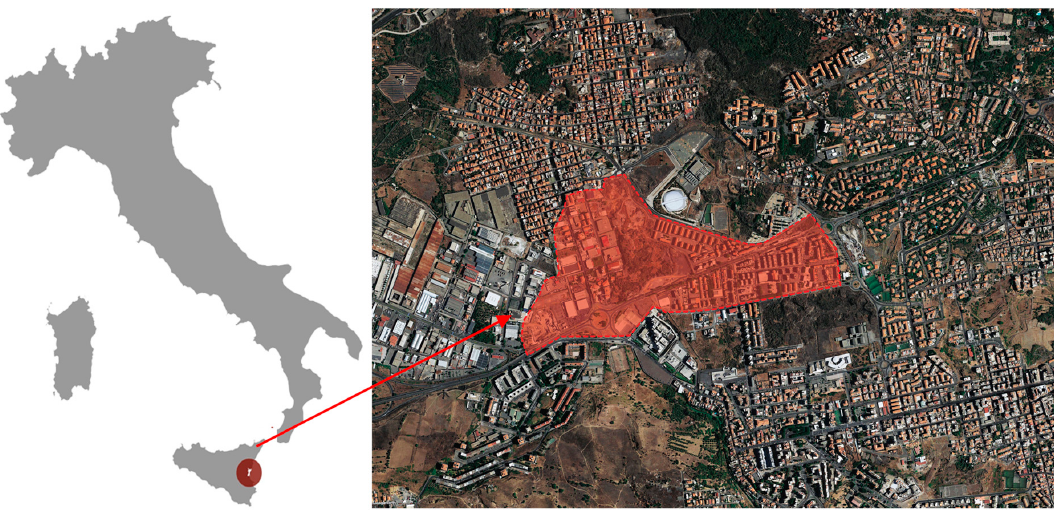
Figure 3. The designed urban area of Catania.